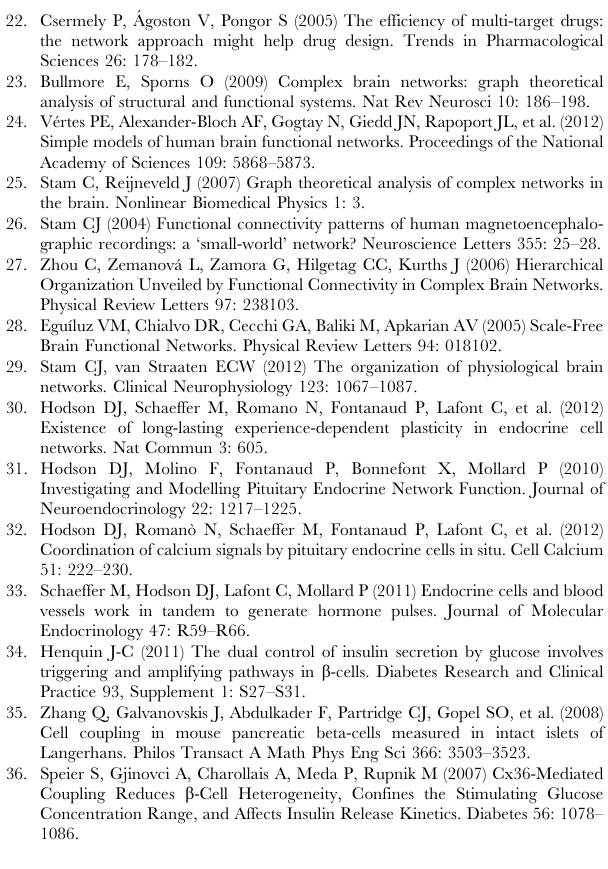
Figure S3 The average correlation coefficient R avg for all pairs of the 562 cells from 9 different slices within a given interval of Euclidean distance. Three of the five regimes are considered: LG1, HG and LG2. Evidently, in the low stimulation regimes the coherence of cellular activity was weakly dependent on the physical distance, whereas on the other hand, in the HG regime an obvious trend of nearby cells being much better correlated than distant ones is observed. Video S1 Cytosolic calcium in cells of an islet of Langerhans before, during, and after exposure to 12 mM glucose. LG1, ON, HG, OFF, and LG2 indicate the five different dynamical regimes considered in this study: